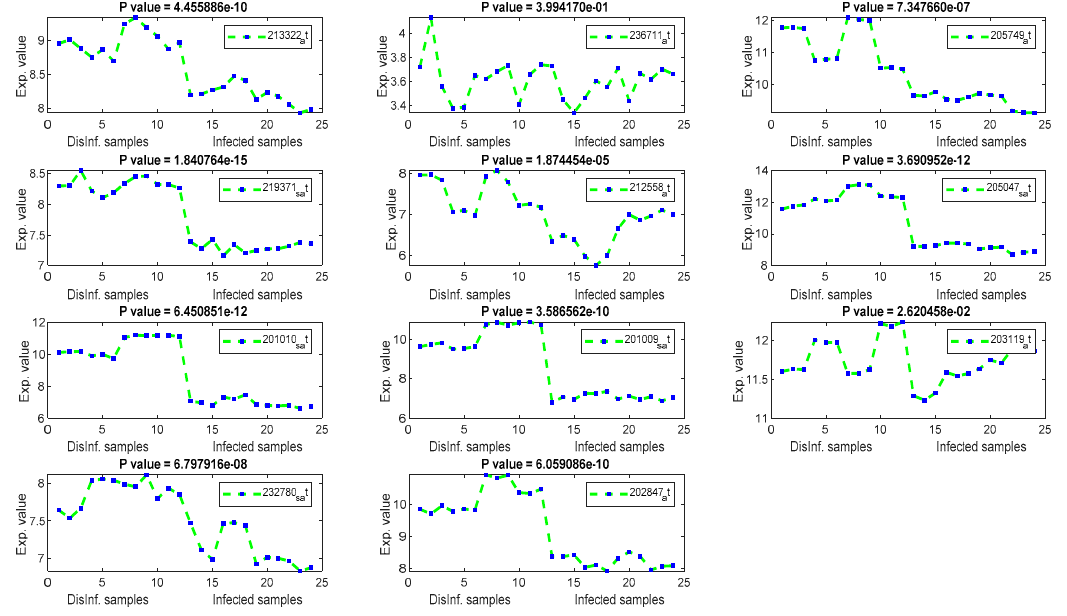
Figure 5. The gene signal profiles of top ranked key genes retrieved using Cosine and Pearson’s correlation.